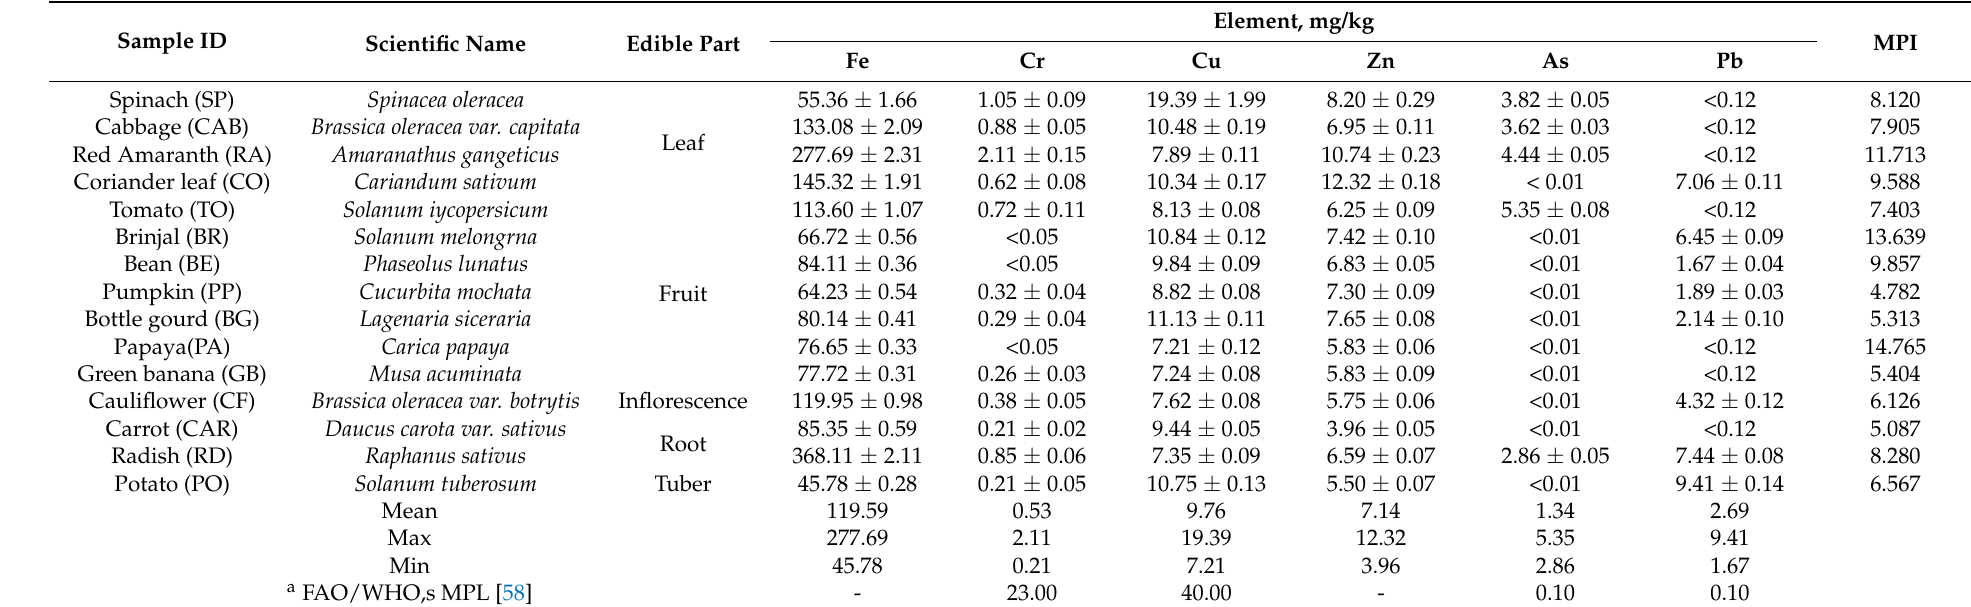
Table 5. Elemental concentrations in vegetable samples and estimated metal pollution index (MPI)